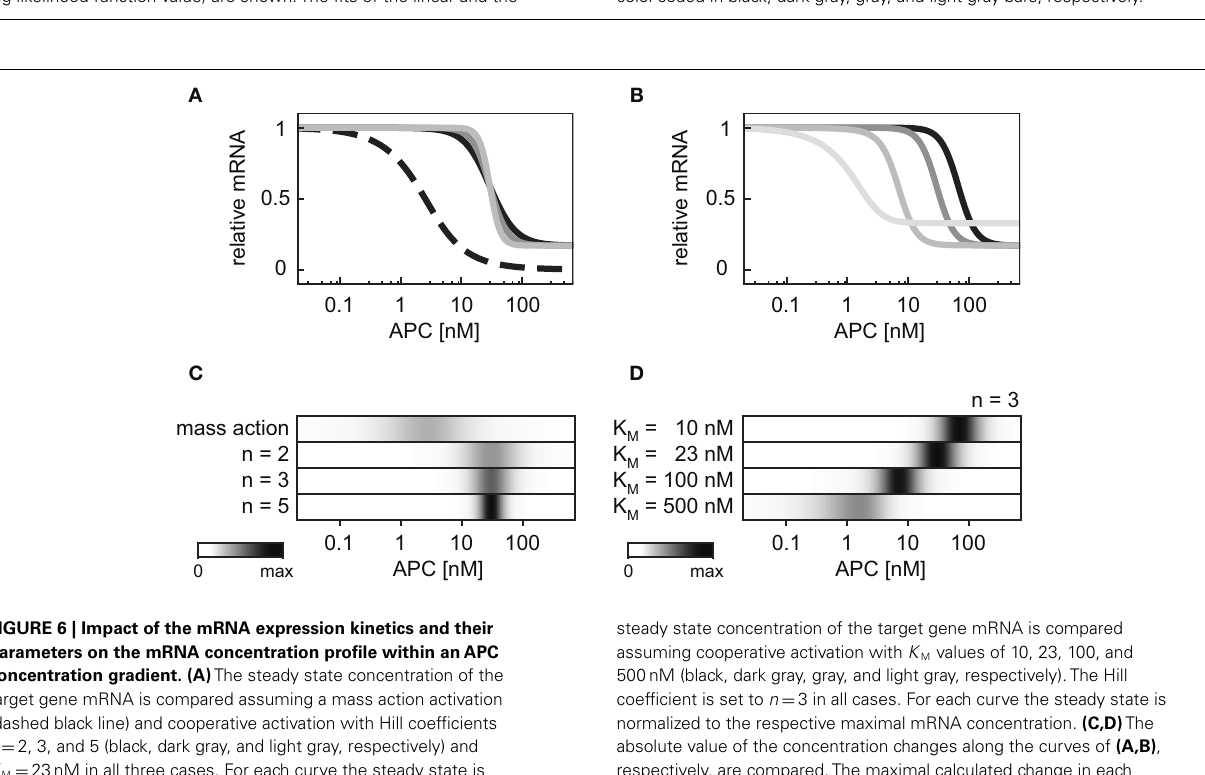
FIGURE 6 | Impact of the mRNA expression kinetics and their parameters on the mRNA concentration profile within anAPC concentration gradient. (A) The steady state concentration of the target gene mRNA is compared assuming a mass action activation (dashed black line) and cooperative activation with Hill coefficients n = 2, 3, and 5 (black, dark gray, and light gray, respectively) and K M = 23nM in all three cases. For each curve the steady state is normalized to the respective maximal mRNA concentration. (B) The